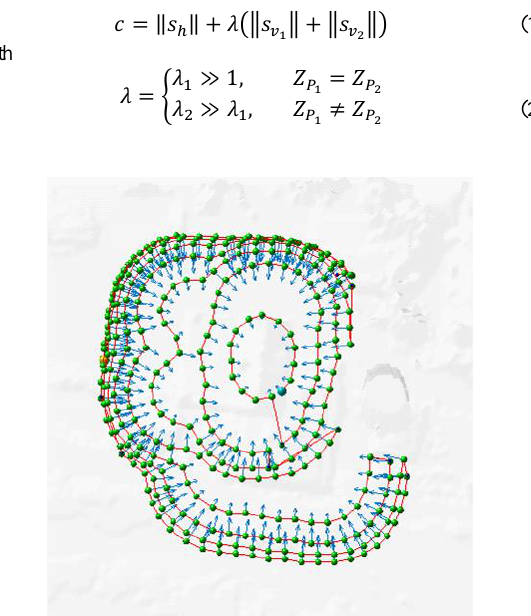
Figure 10. Top view of a flight plan. Green spheres with blue arrows indicate camera stations and corresponding camera alignment.